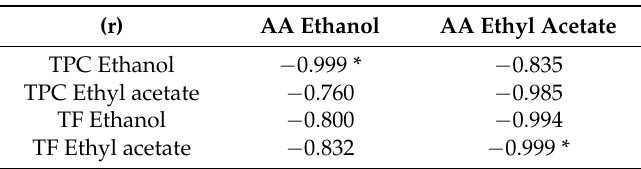
Table 2. The coefficient of correlation ( p < 0.05) between the total phenolic compounds (TPC), total flavonoids (TF) and the values for antioxidant activity